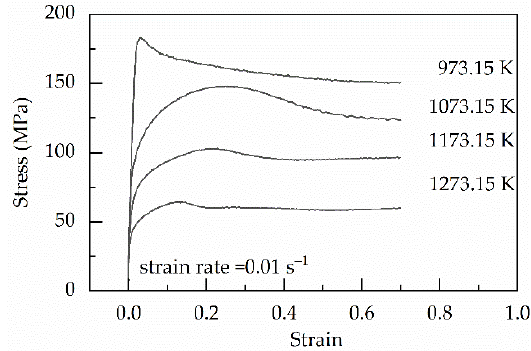
Figure 2. Flow stress curves of isothermally compressed 20Cr2Ni4A alloy steel at a strain rate of 0.01 s − 1 .